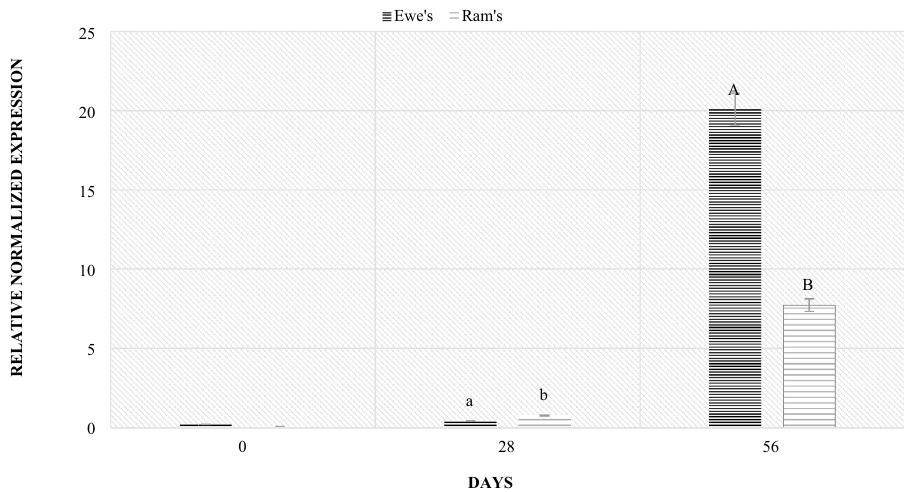
Figure 9. Level of Bacteroidetes (RNE) depending on sex. p < 0.05—A, B, C; p < 0.01—a, b, c.